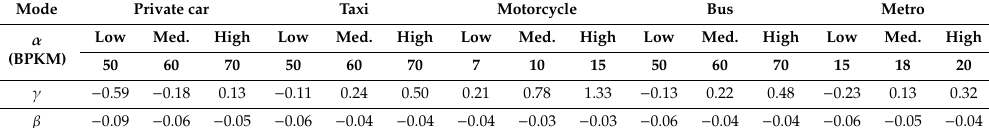
Table 4. Estimated values of γ and β in Equation (2) for the di ff erent saturation levels ( α )